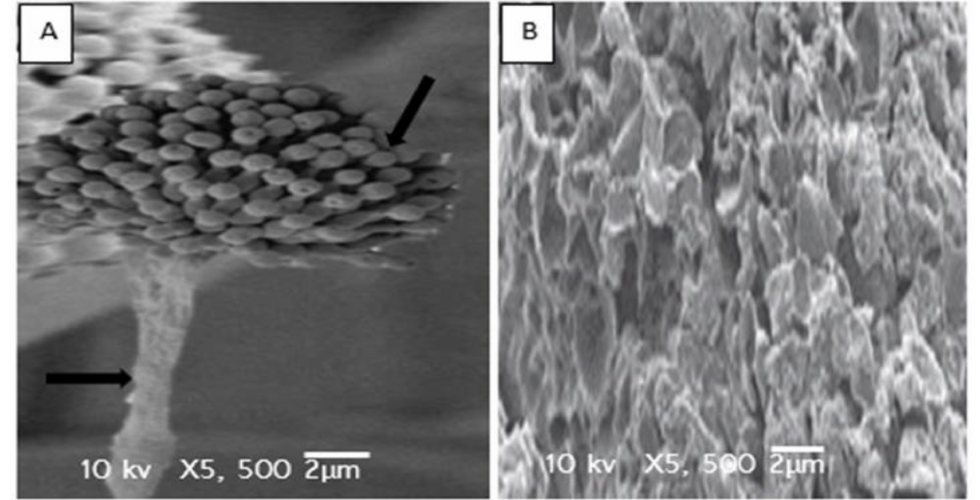
Figure 7. Scan electron microphotographs of untreated ( A ) and treated ( B ) Aspergillus fumigatus